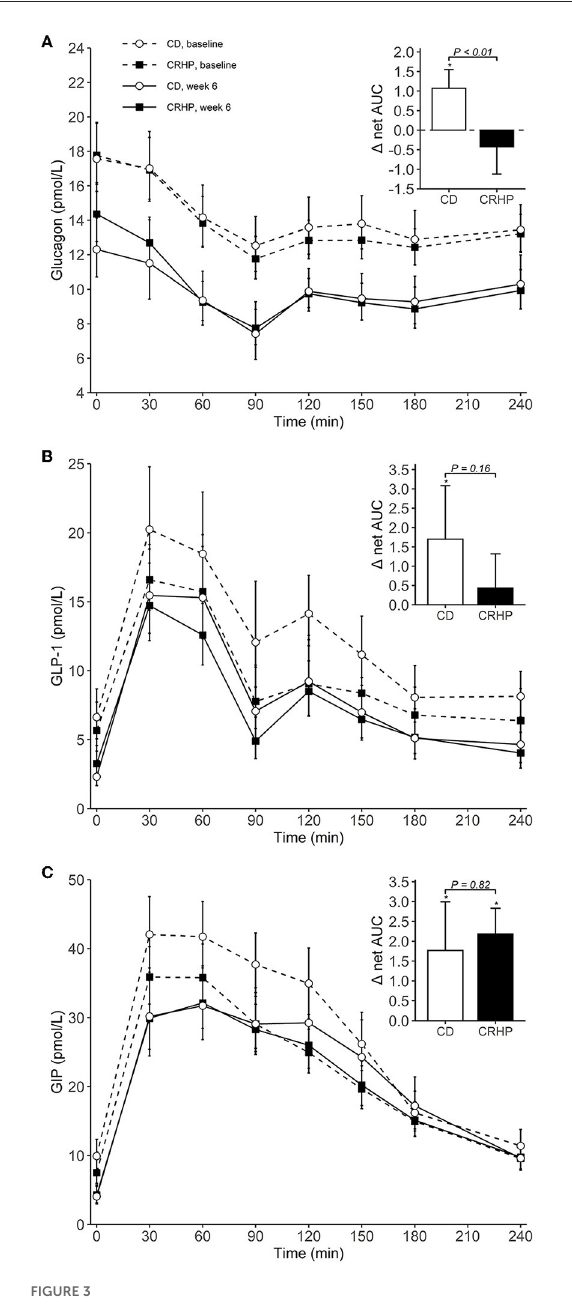
FIGURE3 Plasma concentrations of glucagon (A) , GLP-1 (B) , and GIP (C) during an OGTT at baseline and after 6 weeks of a CD or CRHP diet. Inserted plots represent net AUC in the units stated x 240min. Data are presented as mean ( log-transformation, except for net AUCs; * P < 0.05.